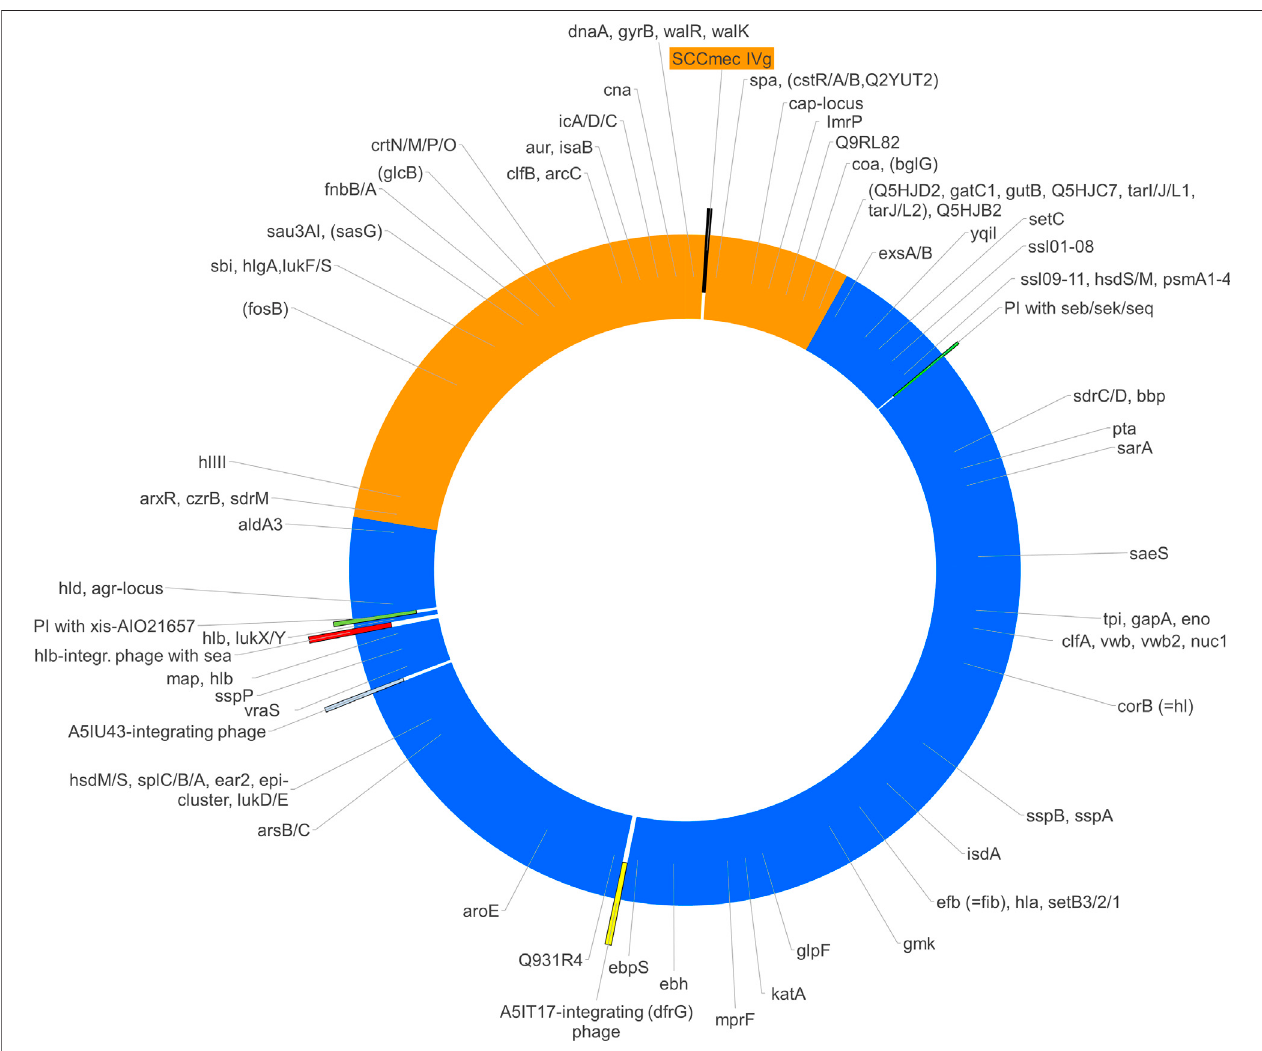
FIGURE 2 | The fi gure shows a schematic representation of the chromosome of S. aureus RGB-095930 including the regions of different provenance (CC8, blue; CC140, orange), the localisations of mobile genetic elements (SCC mec , phages and pathogenicity islands, PI) as well as the approximate positions of relevant genes. Severalofthegenestargeted bythearrayhave conserved positionswithinthe S.aureus genome.Ifpresence, absenceordistinctalleles correlatedwithaf fi liationtoone of the suspected parent lineages, the hybridisation pro fi le can be used to determine the provenance of the part of the genome in which such a gene was localized.